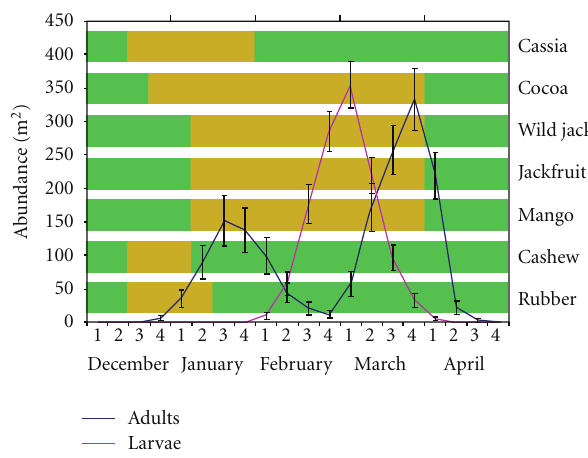
Figure 2: Foliage phenology of the host plants and population buildup of L. tristis in litter habitat during post-rainy breeding and feeding period (abundance data of L. tristis based on [2]; yellow colour depicts peak leaf fall period of evergreen plants and annual leaf shedding period of deciduous plants; blue coloured line depicts adults and pink coloured line